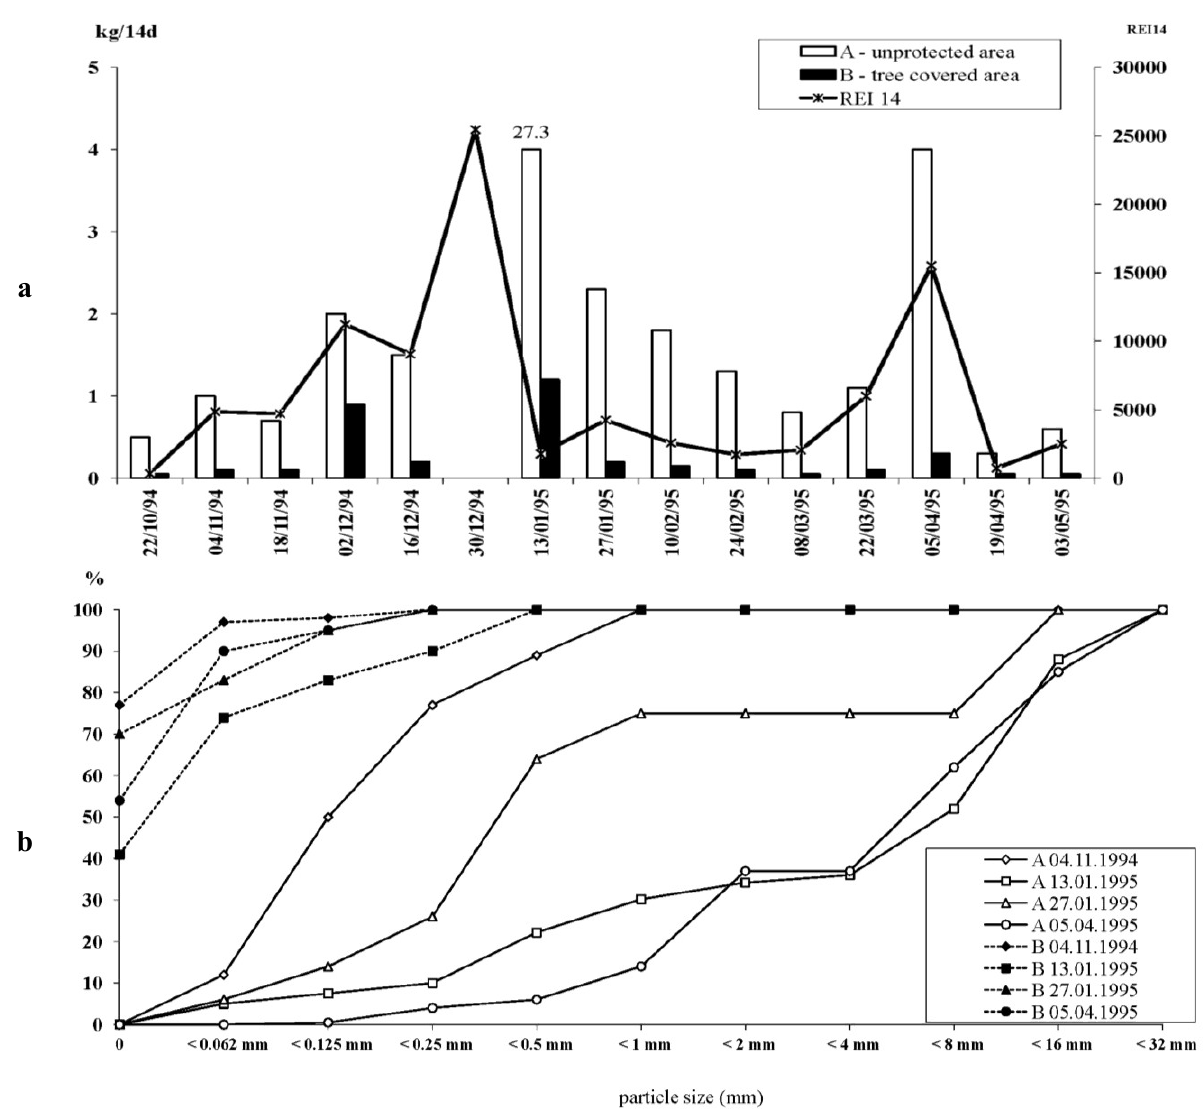
Figure 2. Mobilization of sediment on Wishmeier-plots (2 × 2 m) in the riparian zone of the stream near the mouth of the erosion gully shown in Figure 1c. ( a ) Amount of mobilised sediment (kg per 14day, bars, left axis, a maximum value of 27.3 kg was found on 13.1.1995 for a 4-week interval), REI 14 (RainEventIndex) was calculated as the sum of squares of the rainfall of the 14 days prior to measurement (line, right axis) ( b ) Granulometry of mobilised sediments on Wishmeier-plots from an unprotected site (A) and from a site covered by tree vegetation. Data from Karl M. Wantzen